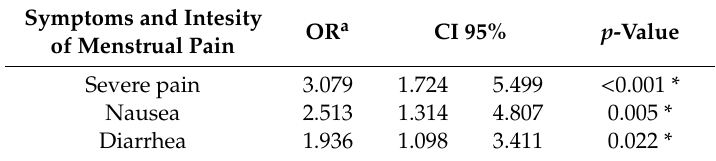
Table 6. Multivariate regression to predict absenteeism from menstrual symptoms and intensity of menstrual